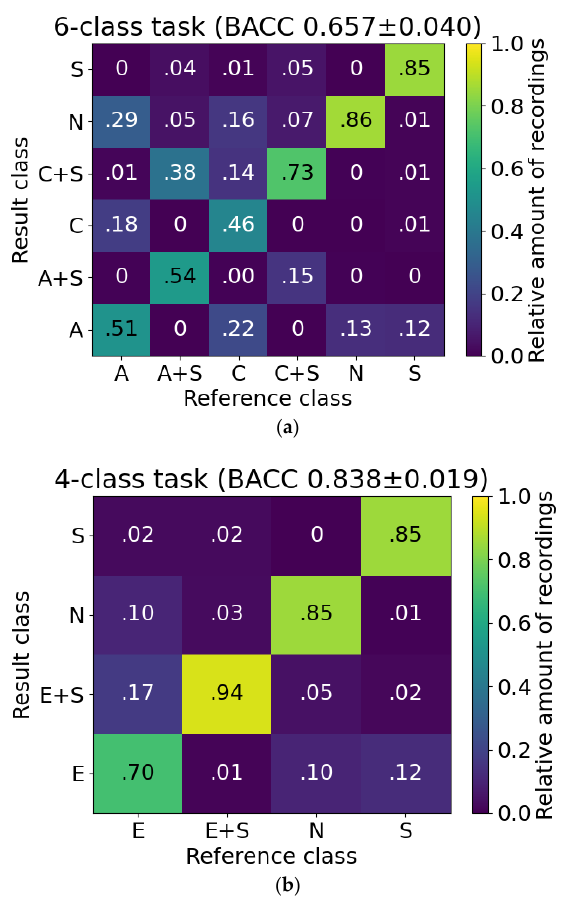
Figure 4. Confusion matrices for ( a ) six-class and ( b ) four-class classification task with